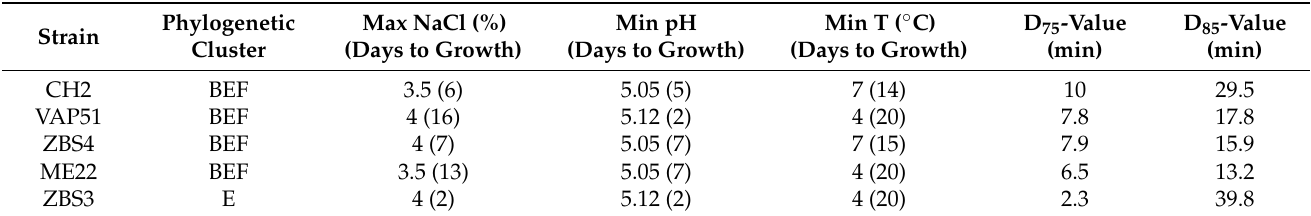
Table 9. Summary of characteristics of nontoxic strains selected for inclusion in a challenge testing strain cocktail. D 85 was determined with lysozyme in the plating